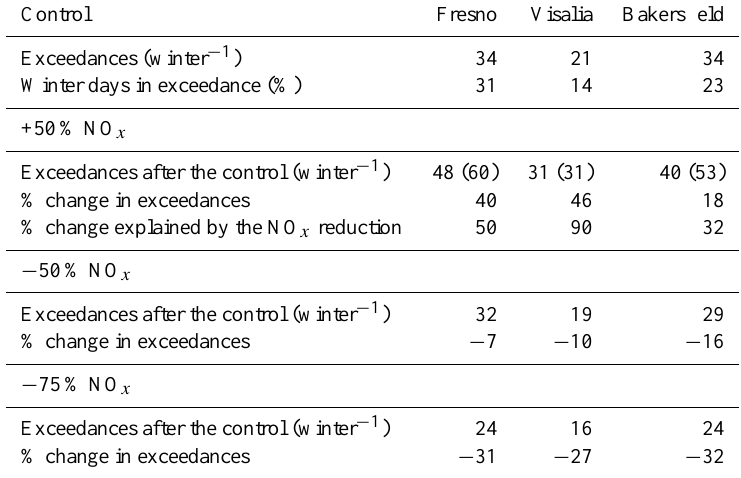
Table 1. Effects of three NO x emission control scenarios on wintertime 24h PM 2 . 5 NAAQS exceedances in Fresno, Visalia, and Bakersfield. Percentages are calculated according to days in which data exist, not total wintertime days. Rows 1–2: average exceedances winter − 1 (November–March) in the last 3 years of the record, rounded up, and percentage of days in violation. Rows 3–9: number of exceedances predicted after a 50% increase (back in time) and 50 and 75% reductions in NO x , including the calculated percent change from present day. In row 3, the number in parentheses is the actual number of exceedances averaged for 2001–2004. In row 5, the number of calculated exceedances was rounded down to compute the percent. Control Fresno Visalia Bakersfield Exceedances (winter − 1 ) Winter days in exceedance